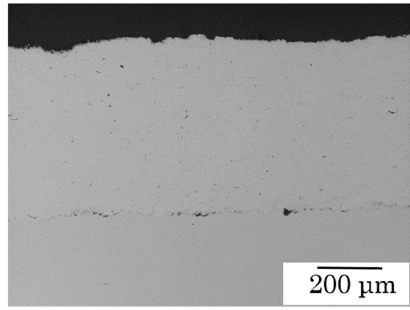
Figure 1. Cross-sectional micrograph of the cold-sprayed AISI 316L coating.